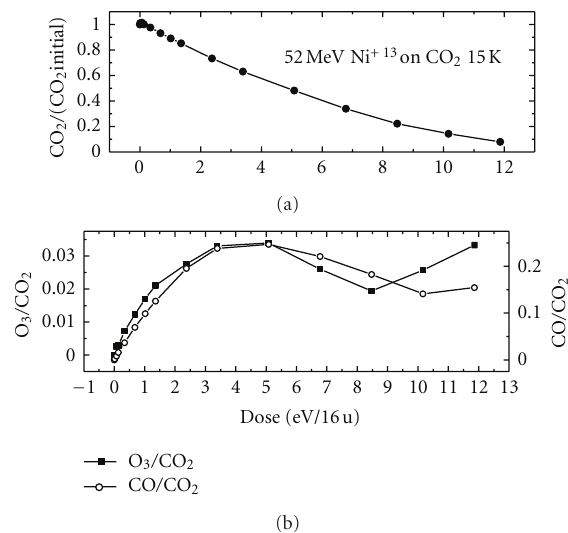
Figure 6: (a) The column density ratio (CO 2 /CO 2 initial) of a pure CO 2 target is shown versus the dose adsorbed by irradiation with 52MeV Ni +13 at 15K. (b) The column density ratios CO/CO 2 (right scale) and O 3 /CO 2 (left scale) is shown versus the dose adsorbed by irradiation of a pure CO 2 target with 52MeV Ni +13 at